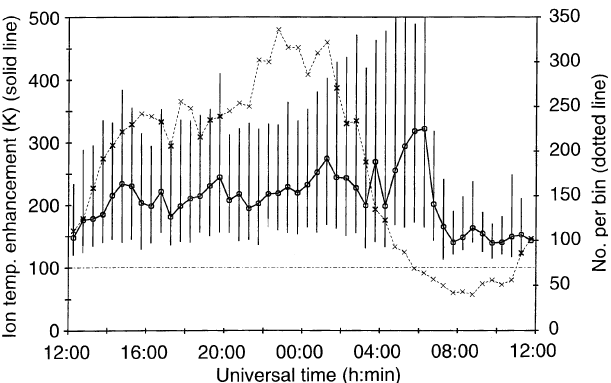
Fig. 2. Enhancement in the field-parallel ion temperature during identified intervals of ion frictional heating, plotted as a function of universal time. The solid line indicates the median temperature enhancement in each 30 min bin, with vertical lines which encompass the range bounded by the upper and lower quartiles. The dotted line illustrates the number of estimates of the enhancement in